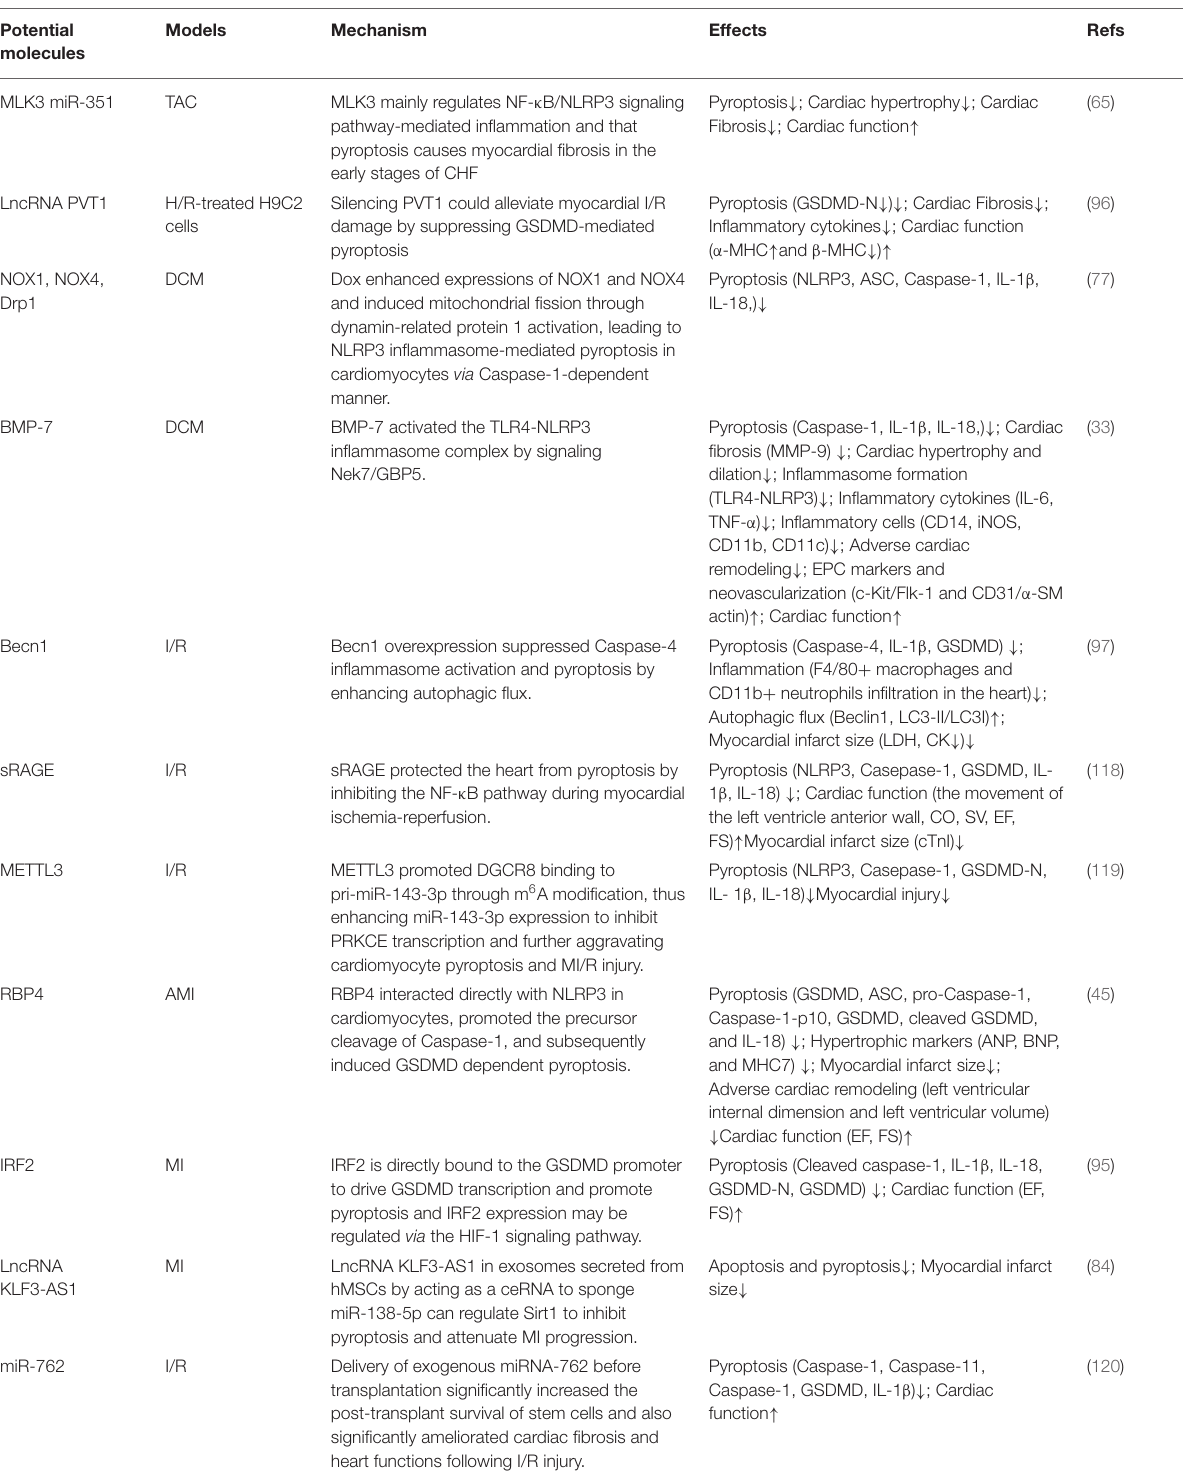
TABLE 2 | Therapy for improving cardiac remodeling by potential molecules on pyroptosis. Potential